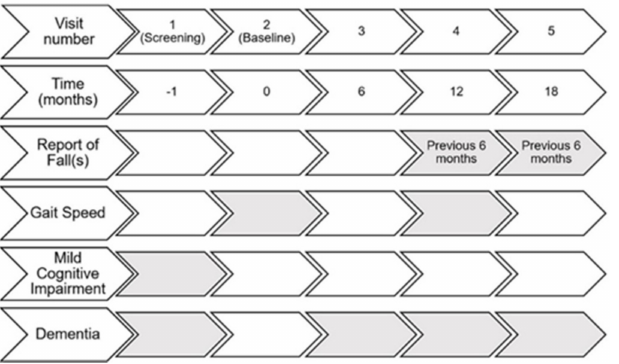
Figure 1. Timeline of GEMS measurements. Shaded boxes indicate when measurement of the variable of interest